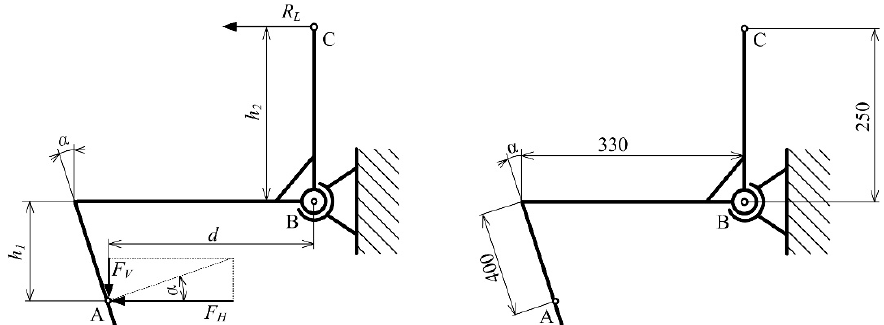
Figure 5. Forces acting on the SRFS and dimensions: A—point of action of forces acting on the cutting blade; B—support point; C—point of action of reaction acting on the load cell; F H —horizontal force; F V —vertical force; R L —load cell reaction force; d, h 1 , h 2 —specific distances; α —inclination angle.